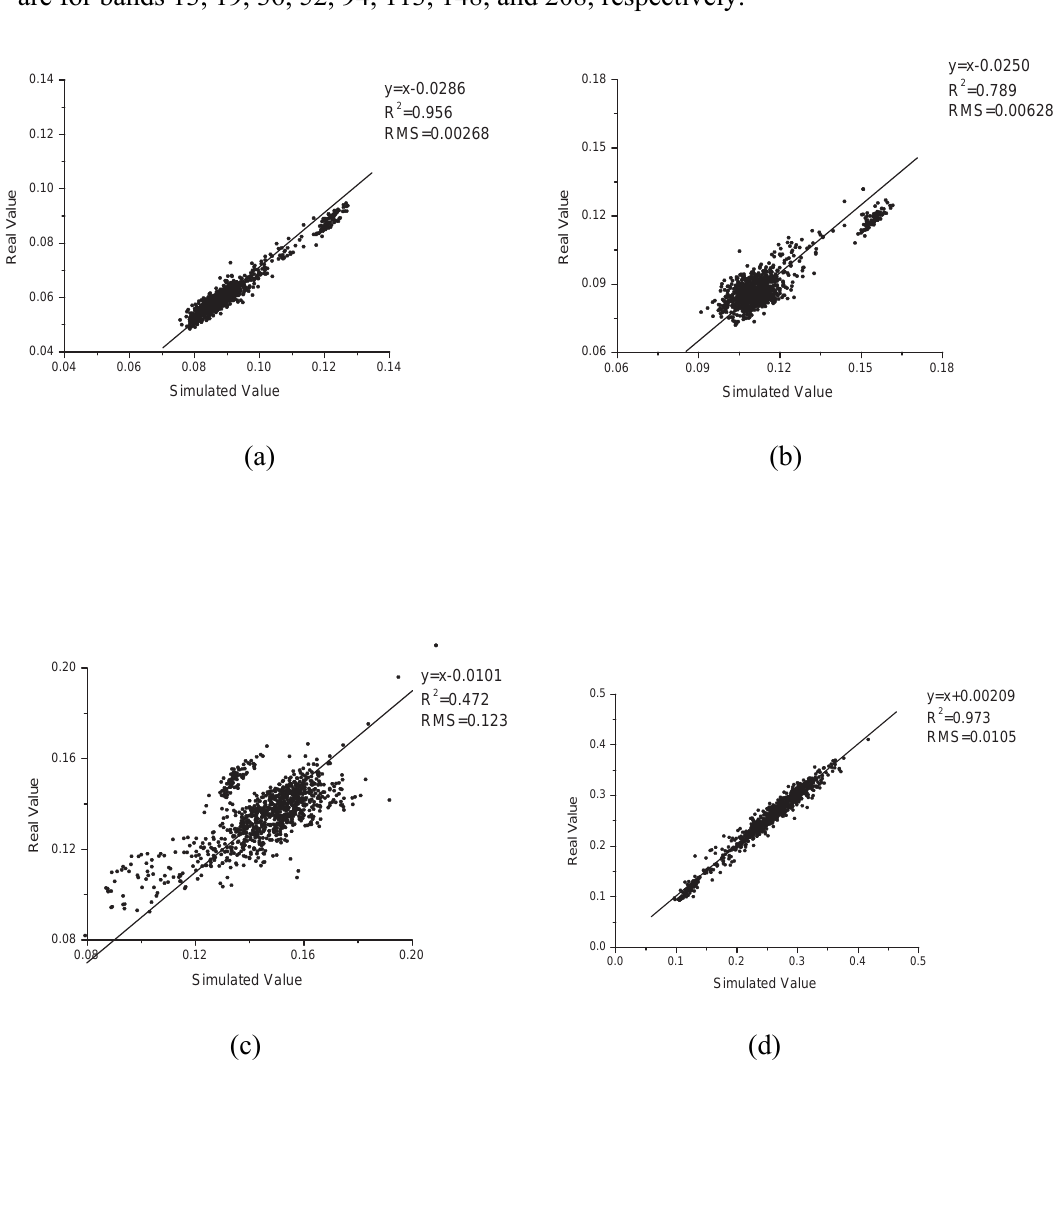
Figure 5 . Linear regression analysis of simulated and original data. Charts from (a) to (h) are for bands 13, 19, 36, 52, 94, 113, 148, and 208,